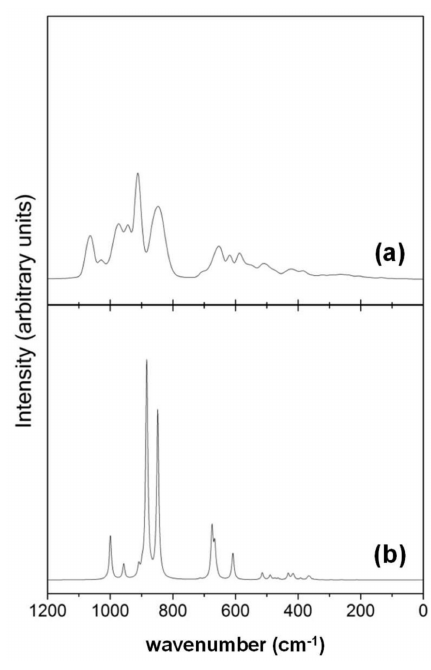
Figure 6. B3LYP-simulated Raman spectra of the amorphous ( a ) and crystalline forsterite ( b